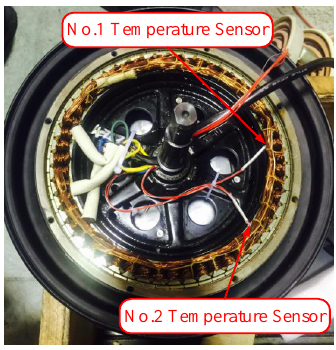
Figure 7. Measuring points of the windings.